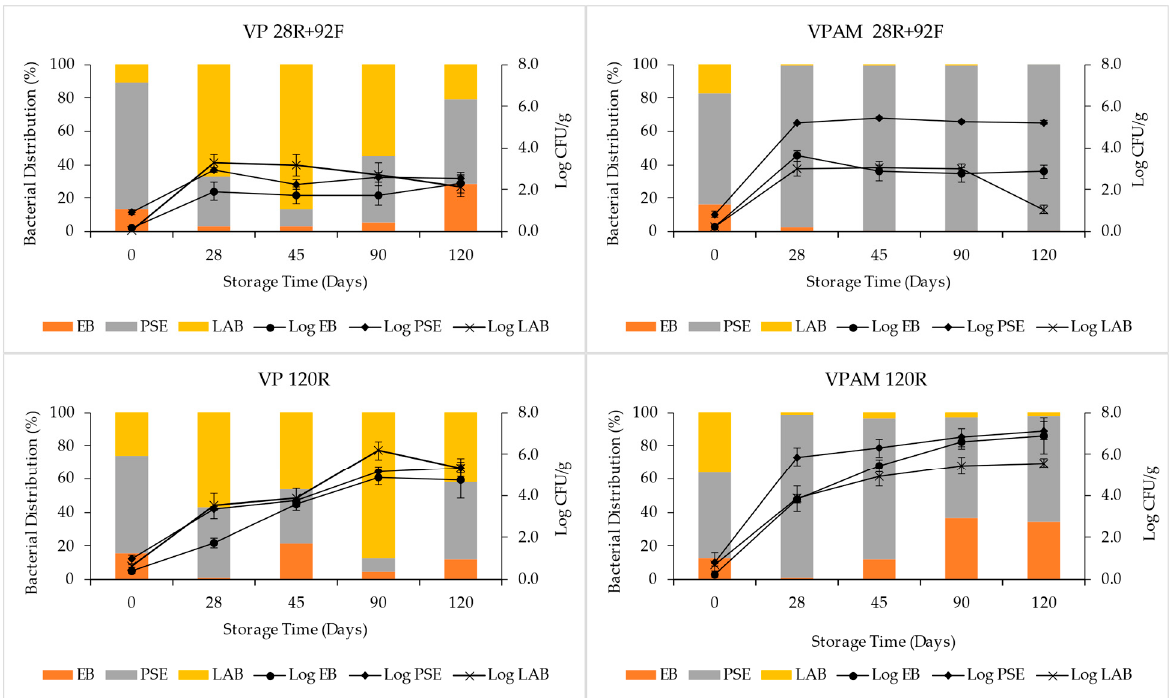
Figure 2. Growth curve and distribution of Enterobacteriaceae (EB) Pseudomonads sp. (PSE), and lactic acid bacteria (LAB) over time in beef treated with different packaging and refrigeration systems stored for 120 days. Treatments: vacuum packaging for 120 days of refrigeration (VP 120R), vacuum packaging for 28 days of refrigeration + 92 days frozen (VP 28R+92F), vacuum packaging with 120 days antimicrobial refrigeration (VPAM 120R), vacuum packaging with antimicrobial for 28 days refrigeration + 92 days frozen (VPAM 28R+92F). log CFU/g, log of colony forming units per gram of beef; error bars indicate the standard error of the mean.